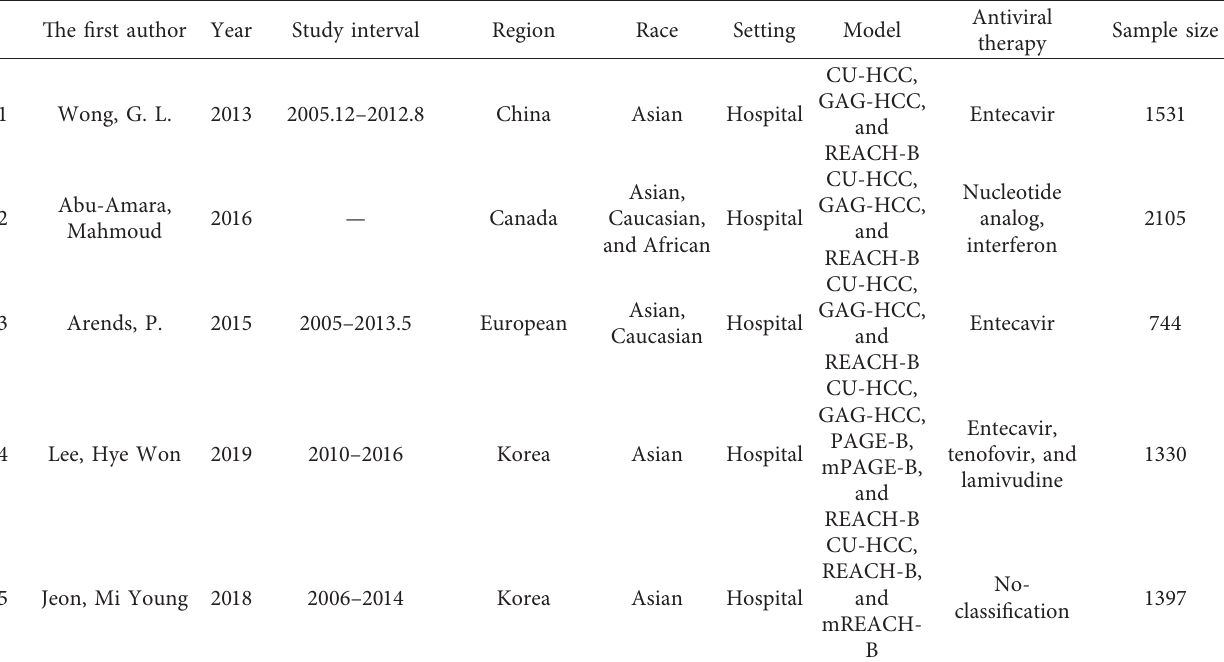
Figure 1: Flowchart of literature search. Table 1: The basic features of included